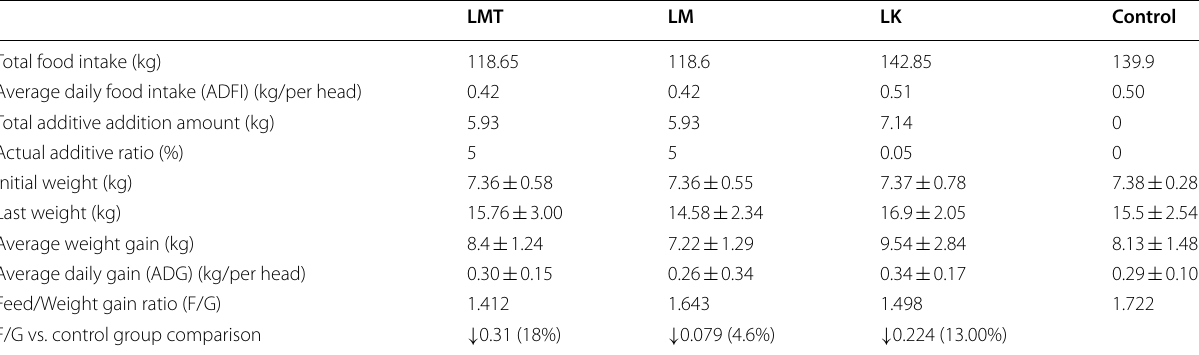
Table 2 Comparison of the growth performance of the local